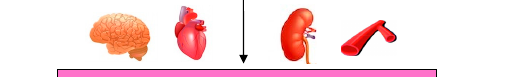
Figure 2. Mechanisms by which reactive oxygen species (ROS) induce endothelial dysfunction-related disease. eNOS, endothelial nitric oxide synthase; NO, nitric oxide; NADPH, nicotinamide adenine dinucleotide phosphate; SOD, superoxide dismutase; LDL, low-density lipoprotein; MAPK, mitogen-activated protein kinase kinases; NF- κ B, nuclear factor-kappa B; AP-1, activator protein-1; VCAM-1, vascular cell adhesion molecule-1; ICAM-1, intracellular adhesion molecule-1; MCP-1, macrophage chemotactic protein 1; EPC, endothelial progenitor cell; VSMC, vascular smooth muscle cell.